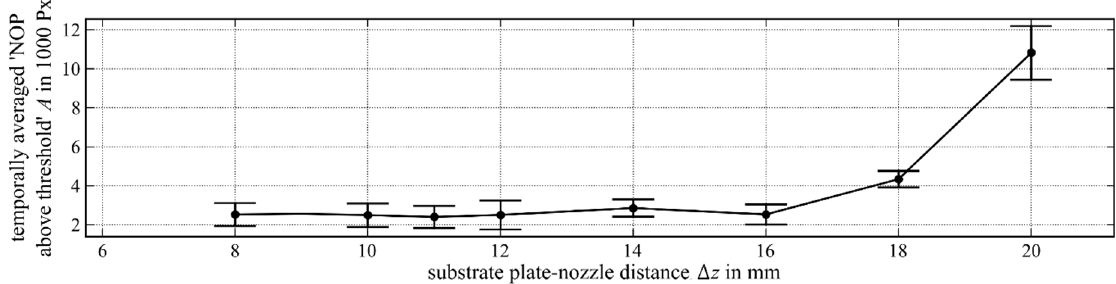
Figure 9. Temporally averaged NOP (intensity threshold 948 digits) over the variation of the substrate plate–nozzle distance.